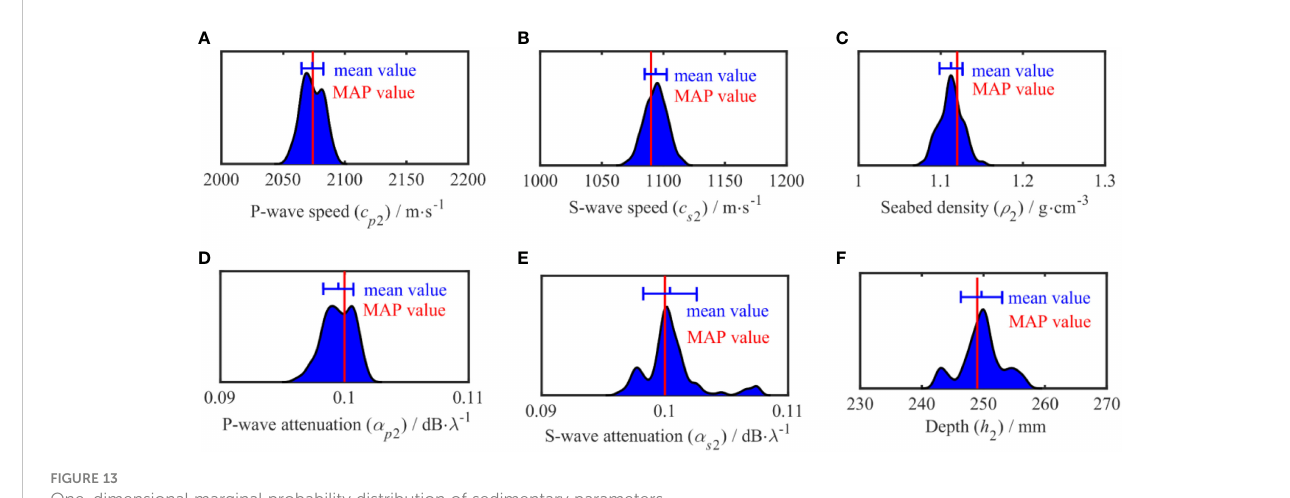
FIGURE 13 One-dimensional marginal probability distribution of sedimentary parameters.